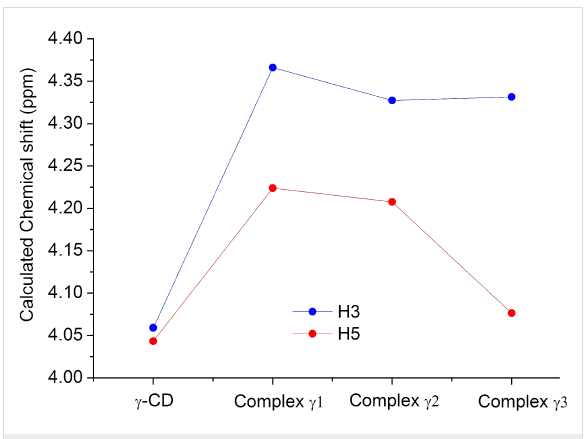
Figure 8: DFT [M06-2X/6-311G(d,p) with D3 dispersion and IEFPCM polarizable continuum solvent corrections] calculated NMR chemical shifts for protons H3 and H5 for neat γ -CD and the γ -CD·aescin theo- retical complexes γ 1, γ 2 and γ